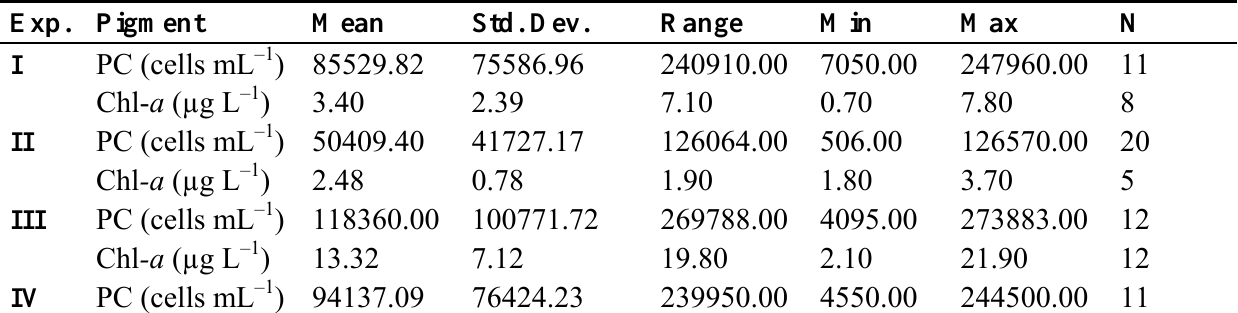
Table 1. Descriptive statistics of pigment measurements in the four proximal sensing experiments. N refers to the total number of readings acquired. Chl-a data was not acquired in Exp.